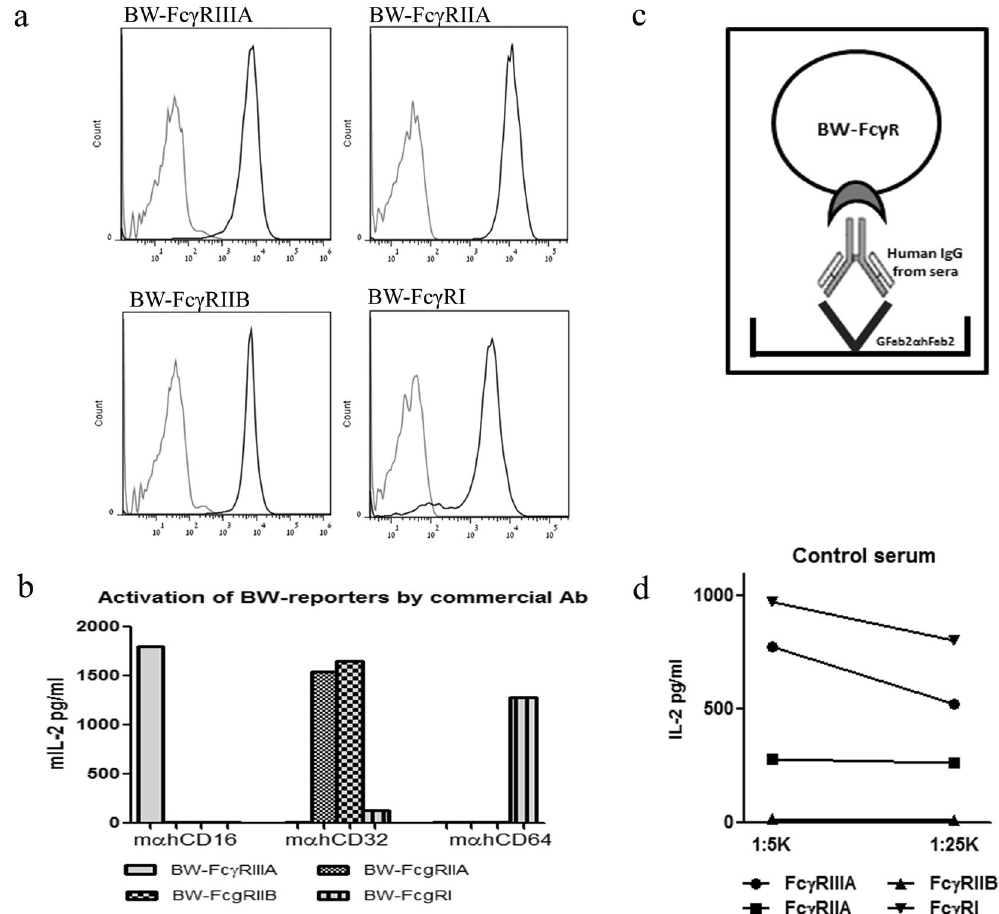
Figure 1. Production and activation of the BW-Fc γ R reporter cells by IgG. ( a ) Detection of stable transfected Fc γ Receptors was screened by flow cytometry using combined staining with anti-human CD-16/ 32/ 64 -black line, secondary APC- grey line. ( b ) Activation of BW reporter cells by commercial mAb. 96-well culture plates were pre-coated with Goat anti-mouse IgG (2 μ g/ml), blocked, washed and coated with mAbs specific for each Fc γ R 250 ng/ml. Following additional washing, BW-Fc γ R cell lines were added, 50 * 10 3 cell/well. mIL-2 secretion was determined by ELISA kit after 16 h incubation. ( c ) IgG mediated activation process diagram of BW-Fc γ R reporter cells. Coating of plates with goat Fab2 portion anti human Fab2 of IgG, adding human sera containing IgG followed by seeding with reporter cells 50 * 10 3 cells/well. mIL-2 secretion of activated cells determined by ELISA after 16 h incubation. ( d ) Activation of BW reporter cells by control sera (1:5 K and 1:25 K dilution). mIL-2 secretion was determined by ELISA after 16 h